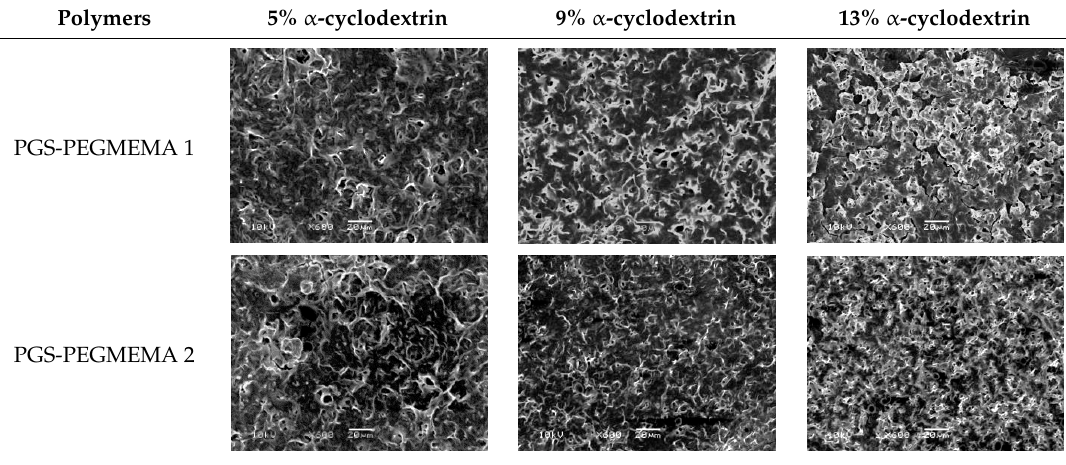
Table 3. Scanning electron microscope (SEM) images of the hydrogel formed with 2% PGS-PEGMEMA and 5%, 9% and 13% of α -cyclodextrin. The hydrogel matrix density increased with increasing α CD concentrations for both PGS-PEGMEMA 1 and 2/ α CD.